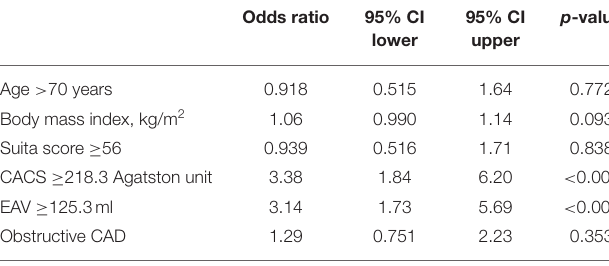
TABLE 5 | Multivariable logistic regression analysis to predict %LAP